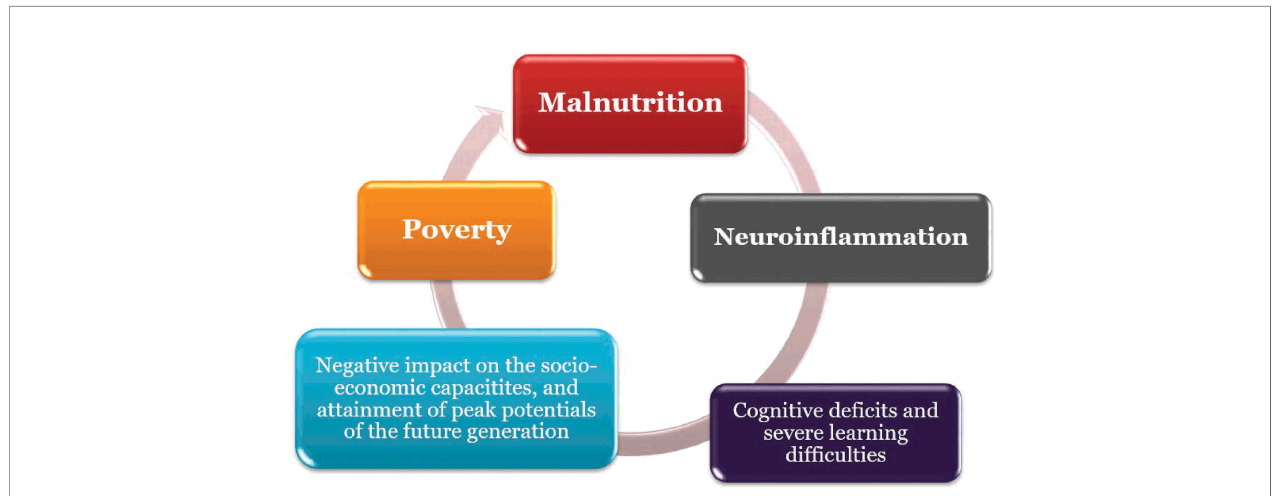
FIGURE 2 | Vicious cycle of Malnutrition, Poverty and Neuroin fl ammation.